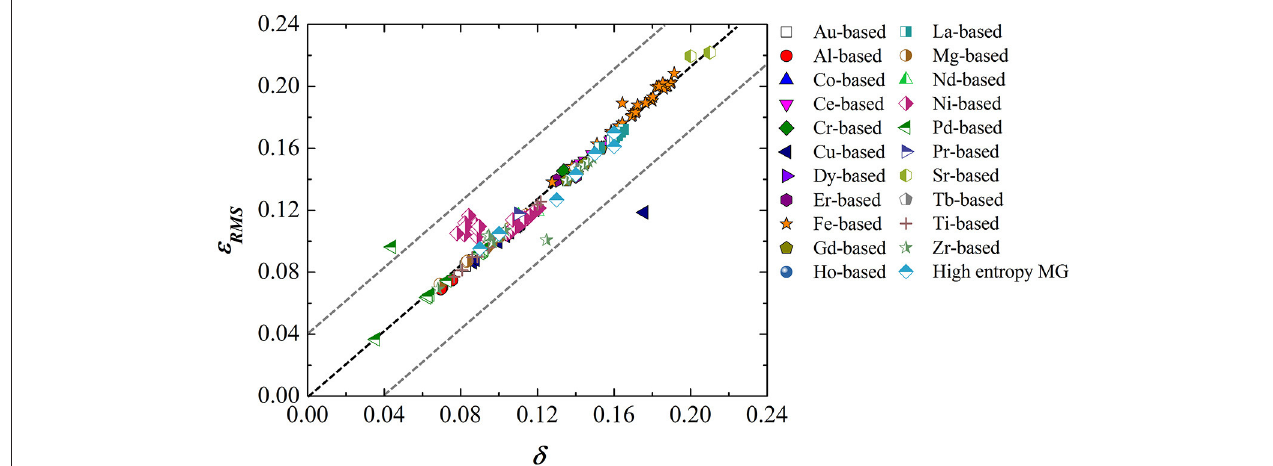
FIGURE 5 | The correlation between the root-mean-square residual strain ε RMS and atomic size difference δ for a variety of metallic glass (MG)-forming alloys.